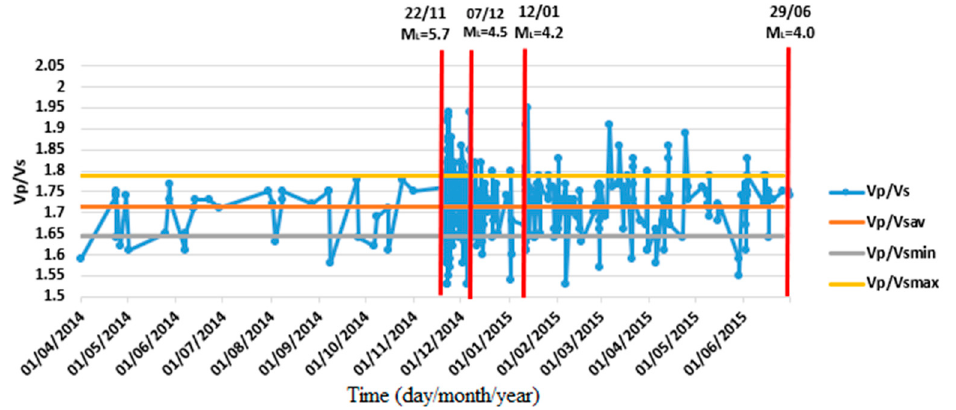
Figure 8. Vp/Vs temporal variation, as determined by the analysis of crustal earthquakes that occurred in the Focsani Basin and surrounding areas during the selected time period (1 April 2014–30 June 2015). Significant earthquakes produced during the specified period are marked with red vertical lines.